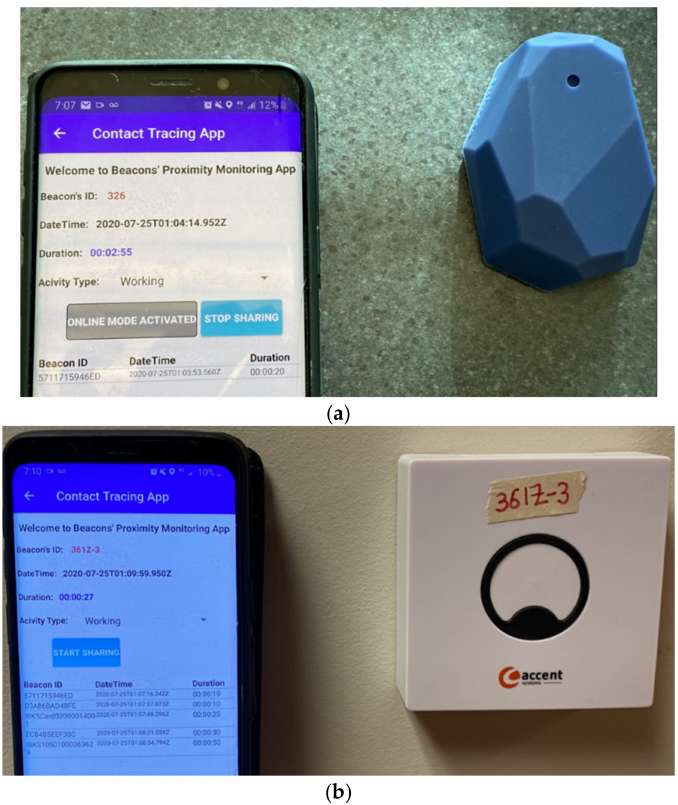
Figure 11. The user interface of the developed app on Samsung Galaxy S9 smartphone capturing the proximity of a user from ( a ) Bluetooth Estimote beacon ( b ) IBKS PLUS beacon.